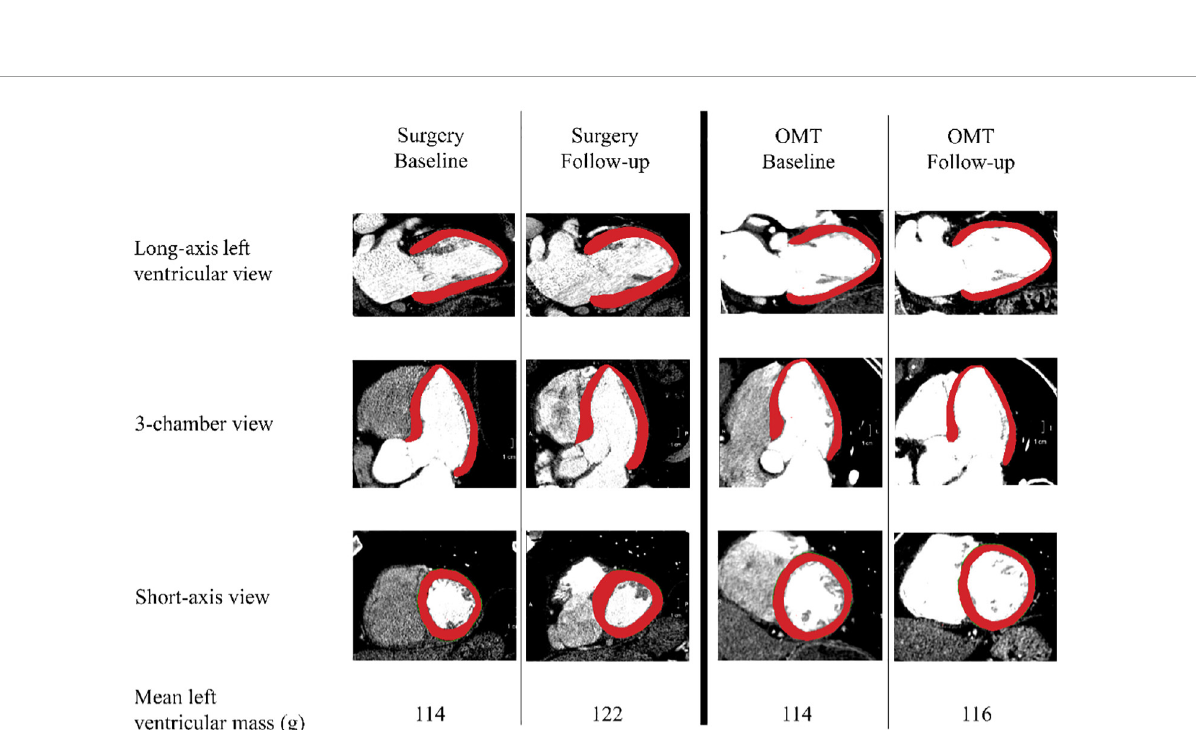
FIGURE2 Measurement methods. Left ventricular mass was calculated by multiplying myocardial volume multiplying by estimated tissue density of 1.055 gr/ml. Surgery and the optimal medical treatment (OMT) group are divided by the thick black vertical line in the middle. Per group, the two columns show an example of a baseline and a follow-up measurement in three different views. The bottom row depicts the mean values of the left ventricular masses in grams for each measurement point per